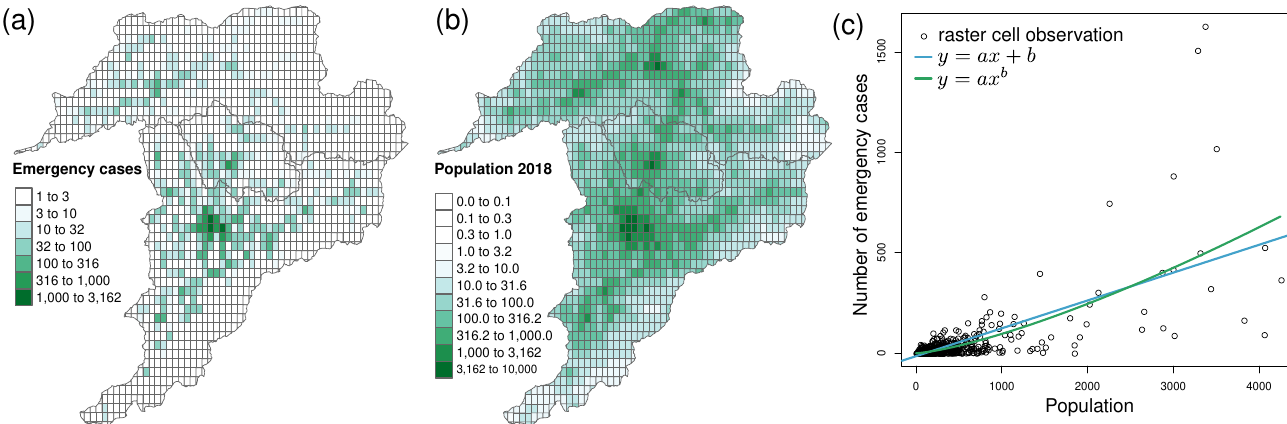
Figure 7. ( a ) Counts of emergency cases (only “sps” and “sphs” trips were considered) in Žilina, Kysucké Nové mesto, and ˇCadca districts. ( b ) Residential population in 2018. In both cases, a raster with the cell size 1500 × 1500 m was used. ( c ) Scatter plot of the number of emergency cases versus the population. Each point in the plot corresponds to a grid cell in panels ( a , b ). Lines show the fit to the data with linear and power functions, respectively.